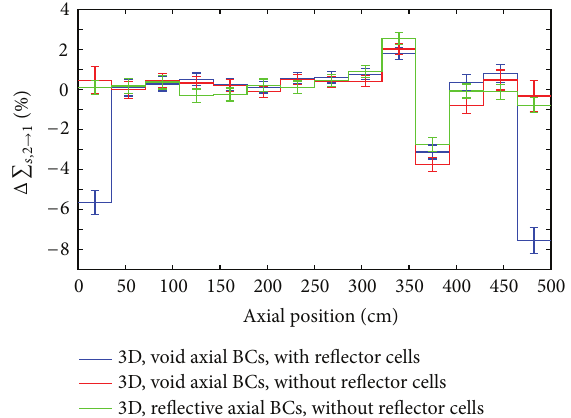
Figure 14: Relative differences between up scattering cross sections.